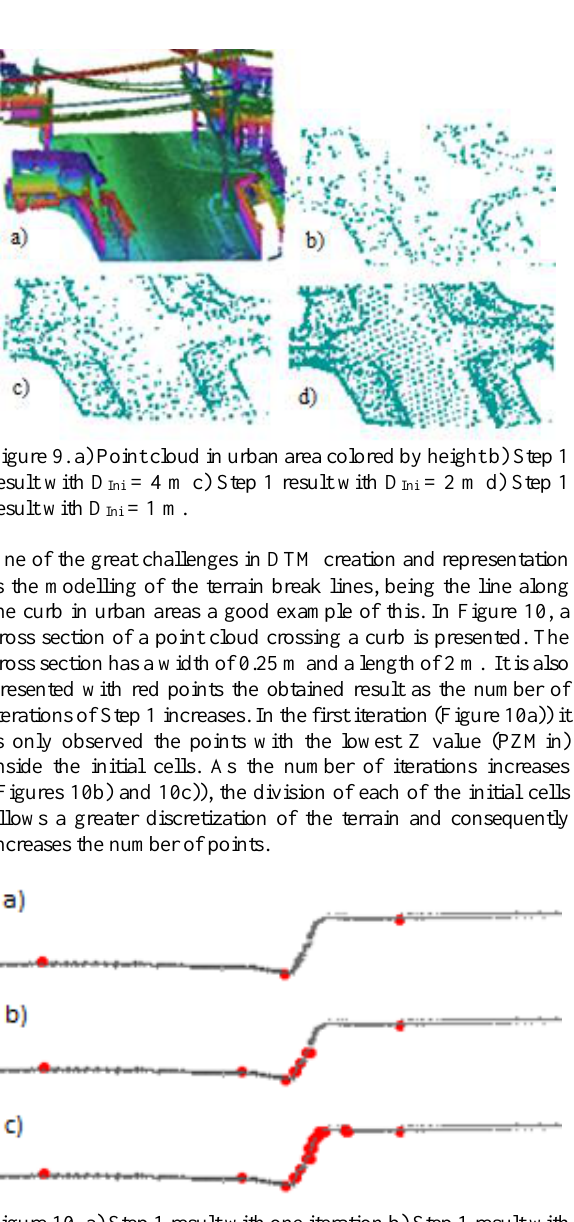
Figure 10. a) Step 1 result with one iteration b) Step 1 result